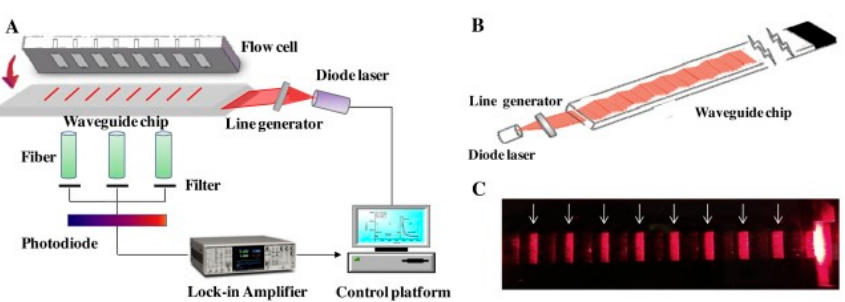
Figure 4. Schematic diagram of ( A ) a prototype array fluorescent biosensor PWAI with a removable multi-channel PDMS flow cell; ( B ) excitation light path inside the planar waveguide transducer; ( C ) photograph of waveguide chip with eight biosensing areas indicated by white arrows. Reproduced from [89].